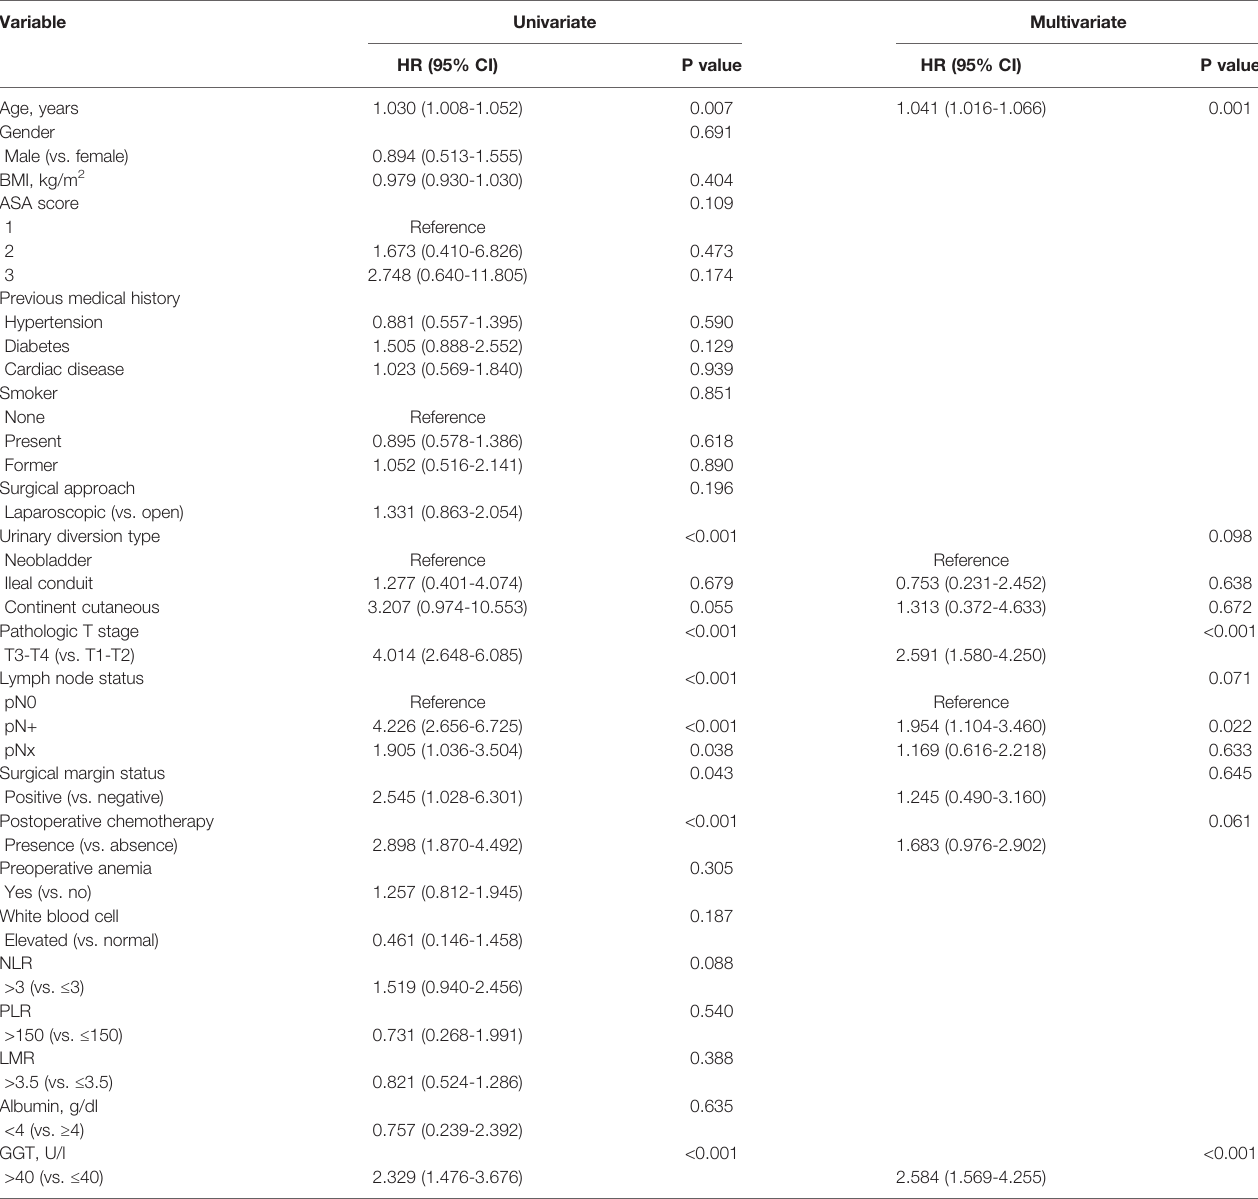
TABLE 4 | Univariate and multivariate analysis for variables predicting progression-free survival.